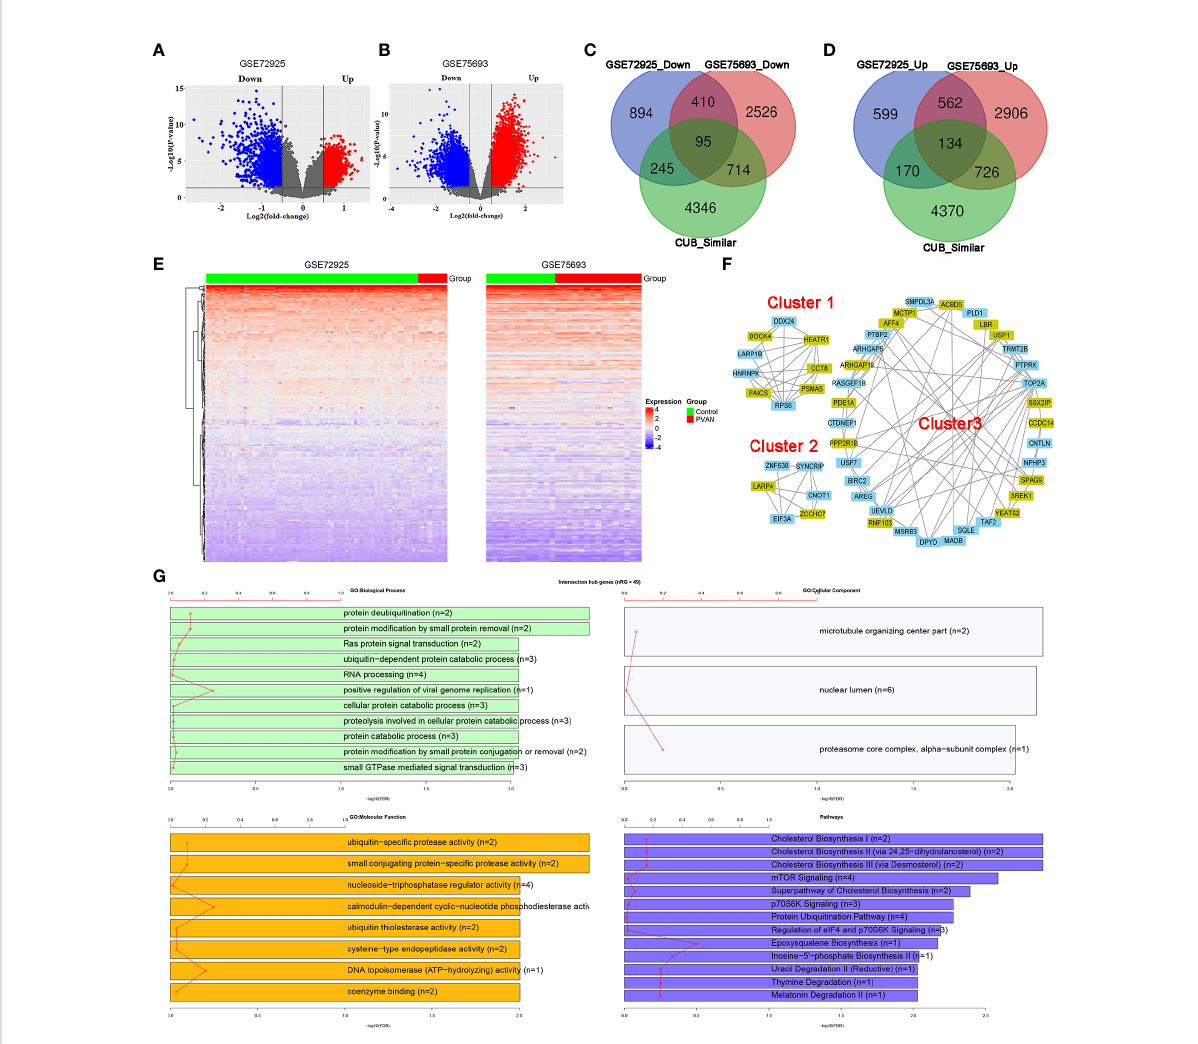
FIGURE 5 Involvement of human genes with CUB similar to that of human HPyVs in PVAN. (A) Volcano plot showing differential expression analysis of genes in GSE72925. (B) Volcano plot showing differential expression analysis of genes in GSE75693. (C) Venn diagram showing the intersection between downregulated DEGs from GSE72925, downregulated DEGs from GSE75693 and human genes with CUB similar to that of HPyV genes. (D) Venn diagram showing the intersection between upregulated DEGs from GSE72925, upregulated DEGs from GSE75693 and human genes with CUB similar to that of HPyV genes. (E) Heatmaps of the expression pro fi le of the 229 human genes with CUB similar to that of HPyV genes that were consistently and differentially expressed in GSE72925 and GSE75693. (F) Hub genes of the PPI network of human genes with CUB similar to that of HPyV genes that were consistently and differentially expressed in GSE72925 and GSE75693 from the fi rst three cluster generated by MCODE. The green nodes indicate downregulated DEGs while the other nodes were upregulated DEGs. (G) Functional enrichment of hub genes of the PPI network of human genes with CUB similar to that of HPyV genes that were consistently and differentially expressed in GSE72925 and